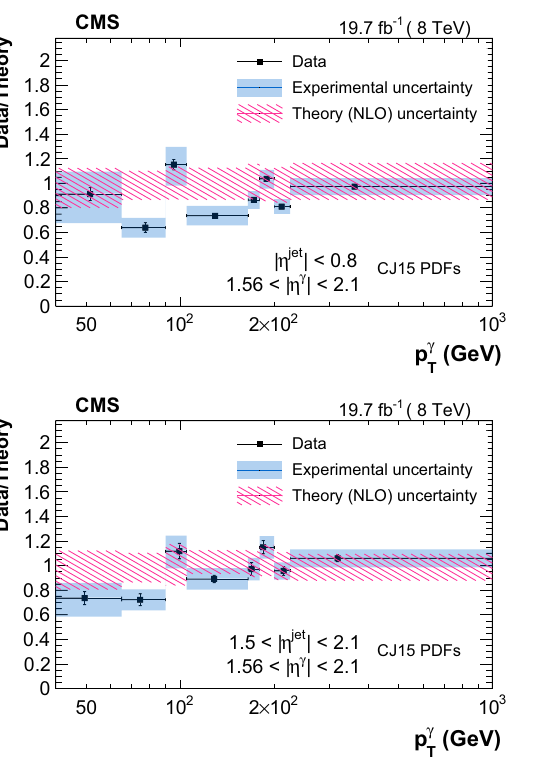
γ 1 . 56 < | η γ | < 2 . 10. Error bars on the data are statistical uncertainties, T and blue bands represent the systematic